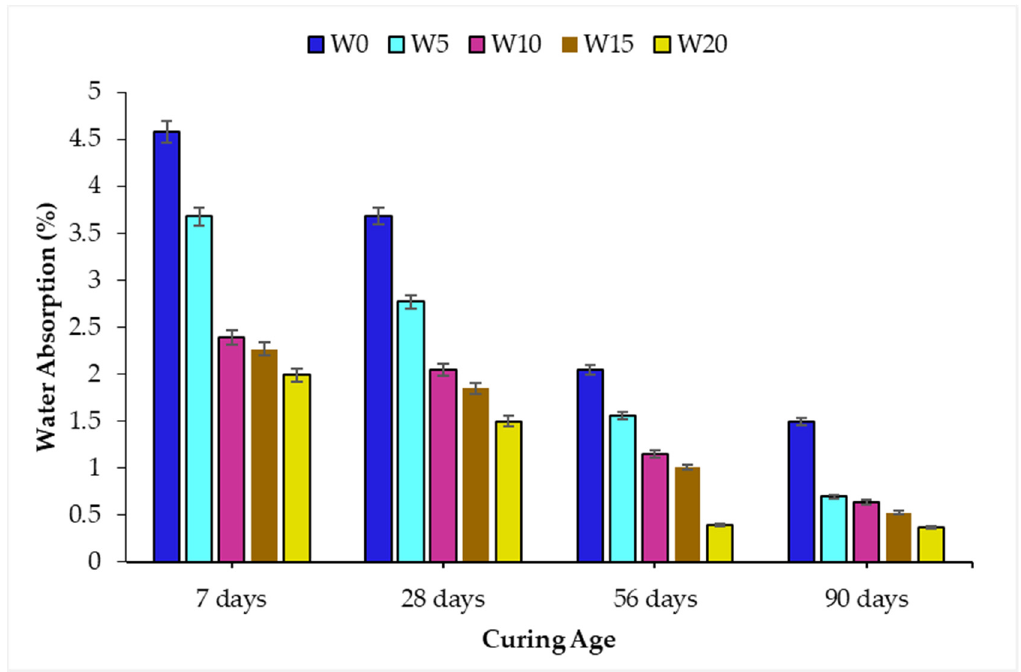
Figure 13. Water absorption of WSA incorporated